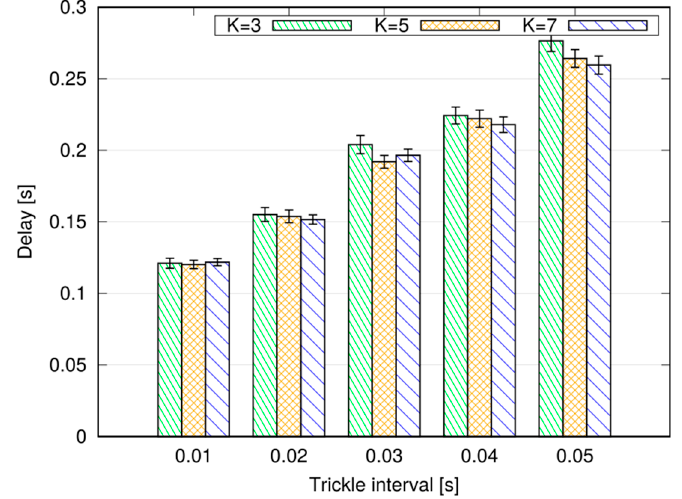
Figure 12. 95th percentile of application-level delay with different settings of the Trickle algorithm.